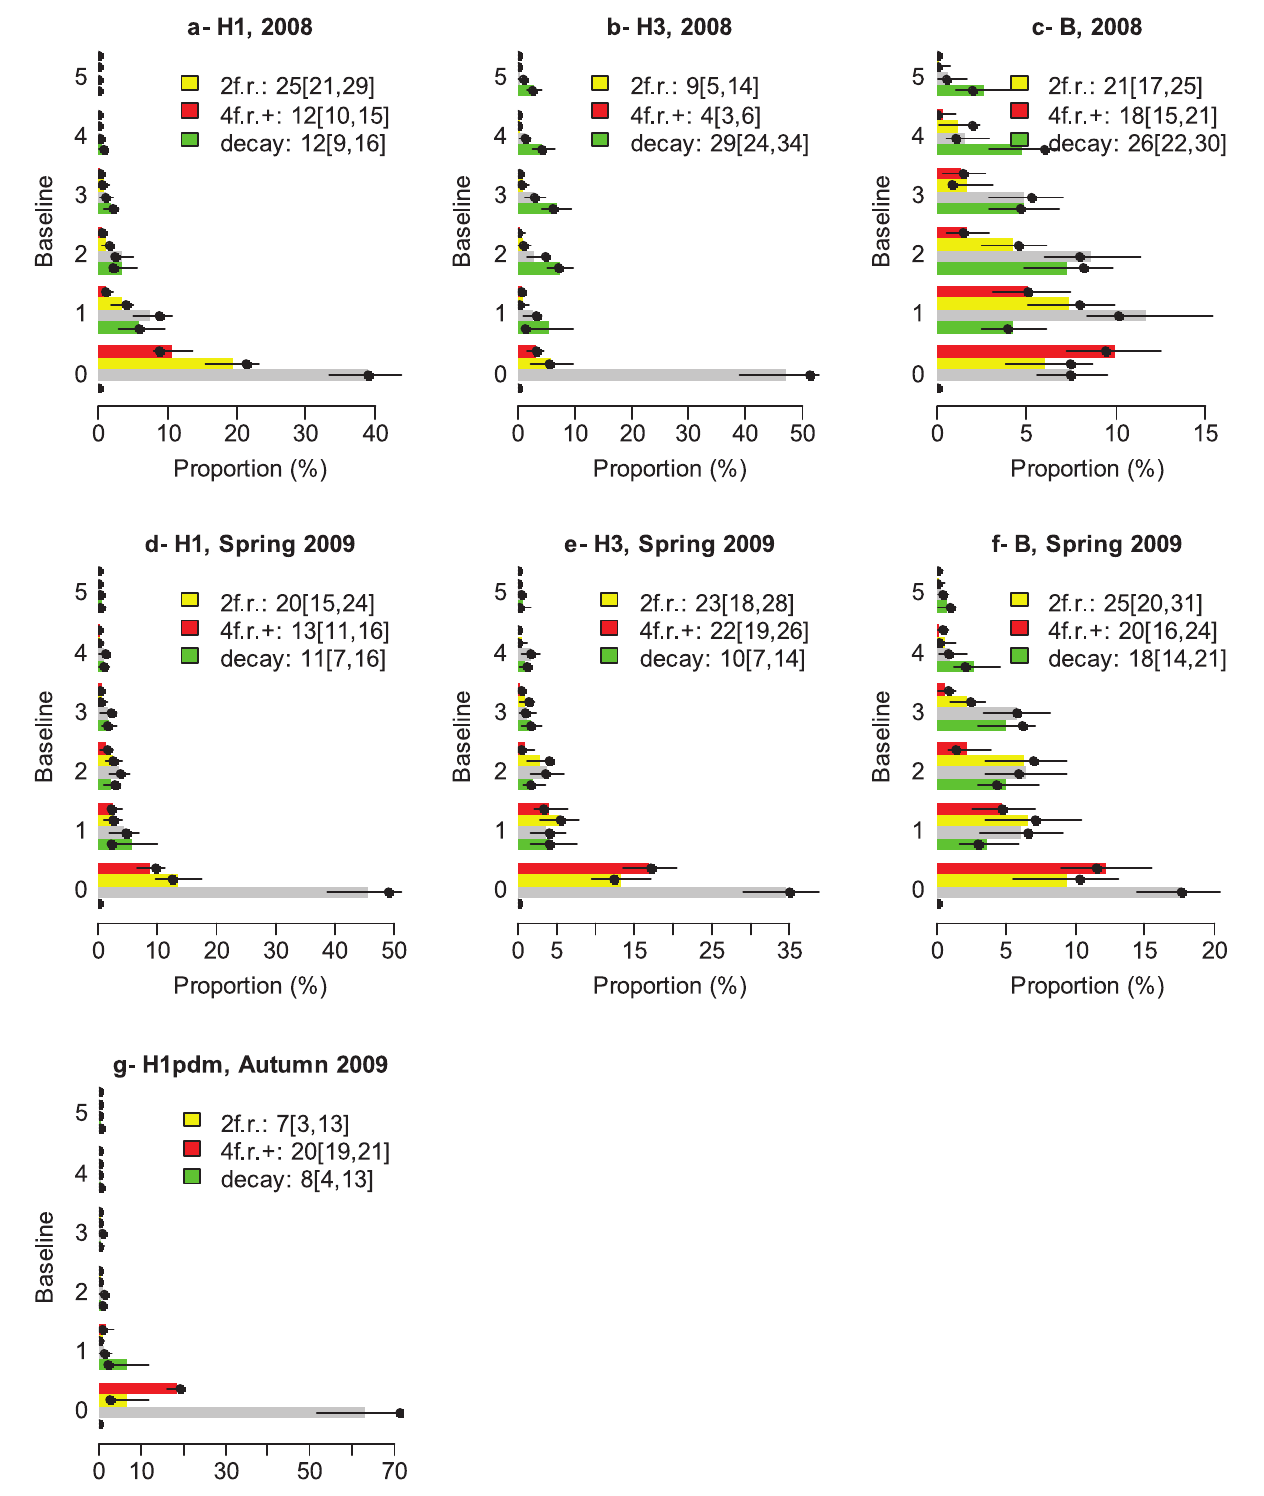
Figure 5. Model adequacy to the data. Distribution of ‘‘observed’’ paired serology as predicted by the model (color bars) and as observed in the data (black point) as a function of season (2008, Spring 2009, Autumn 2009) and subtype (H1N1, H3N2 and B). In each panel, individuals are sorted by baseline AT levels on the y-axis. For a given baseline, the grey bar indicates the expected proportion of individuals with post AT level equal to baseline AT level; the yellow bar indicates the proportion with a 2 fold rise (2f.r.); the red bar indicates the proportion with a 4 fold rise or more (4f.r. + ); the green bar indicates the proportion with a decay. The black thin lines give the 95% CI. The legend gives the mean [95% CI]. A : H1N1, 2008. B : H3N2, 2008. C : B, 2008. D : H1N1, Spring 2009. E : H3N2, Spring 2009. F : B, Spring 2009. G : H1N1pdm09, Autumn 2009.